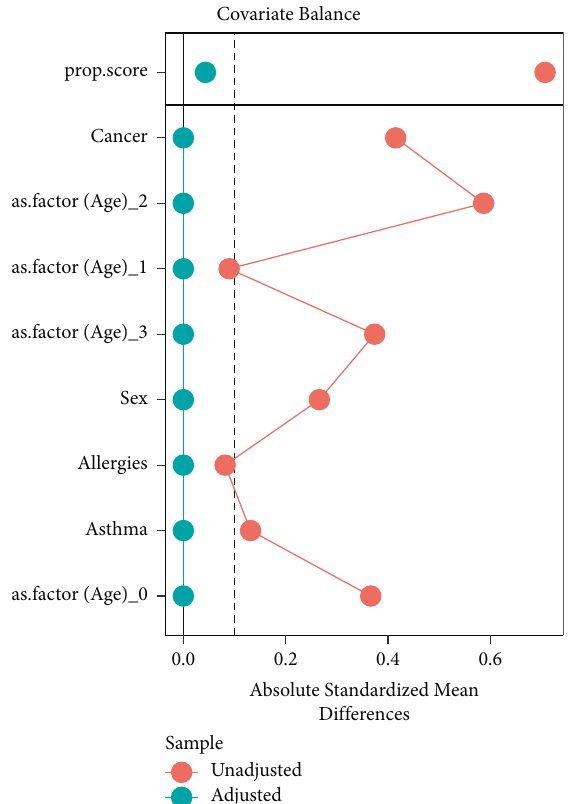
Figure 2: Comparison of standard mean difference before and after PSM.